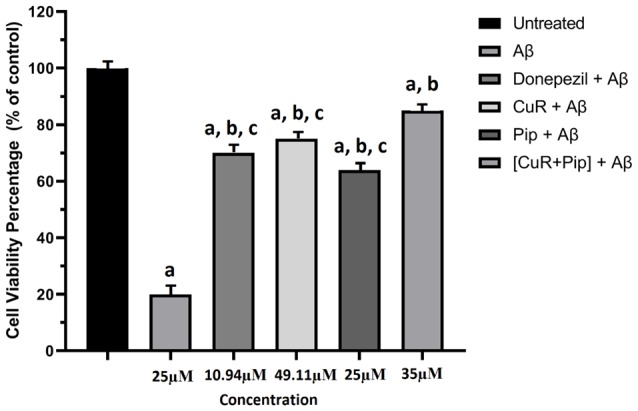
Effects of amyloid β (Aβ), Donepezil + Aβ, curcumin + Aβ (CuR + Aβ), piperine + Aβ (Pip + Aβ), and combined curcumin and piperine + Aβ [(CuR + Pip) + Aβ] in SH-SY5Y cell proliferation after 24 h treatment. The cell viability percentage was calculated relative to the untreated group and expressed as the mean ± SEM. ap < 0.05 compared to untreated cells, bp < 0.01 compared to the Aβ group, cp < 0.01 compared to the (CuR: Pip) + Aβ group (one-way ANOVA followed by Tukey’s test).